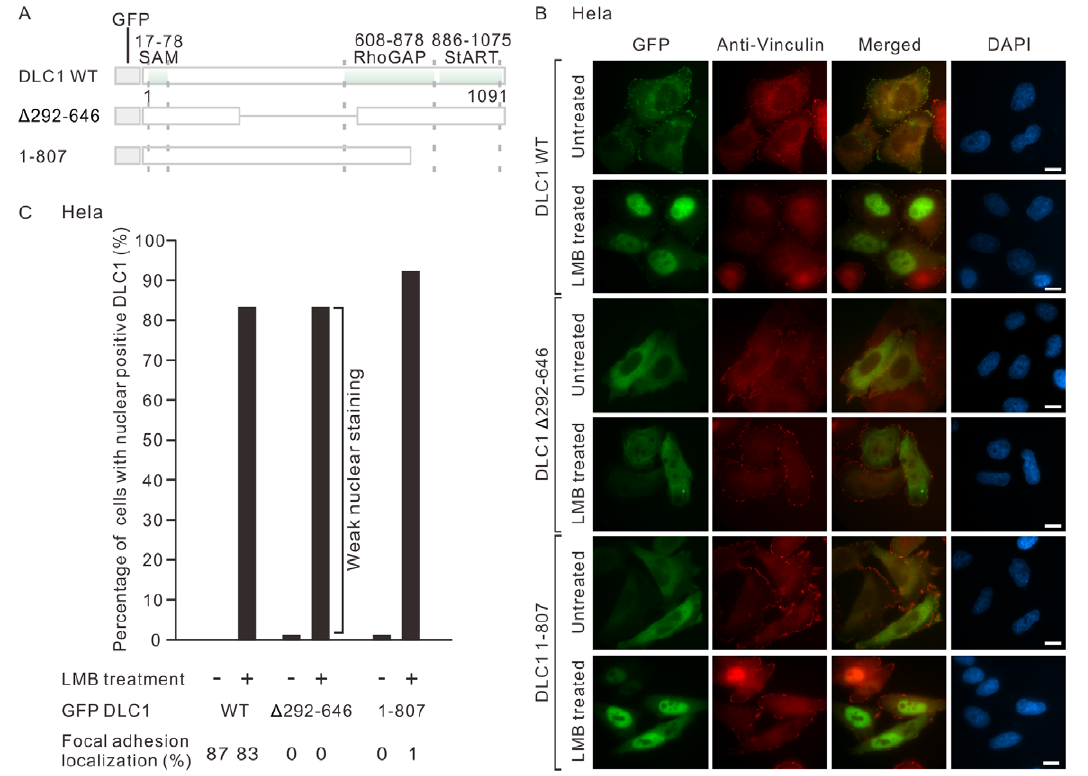
Figure 2. Center region of DLC1 was important for its nuclear localization. ( A ) Schematic diagram showing the structure of wildtype DLC1 (DLC1 WT) and its deletion mutants ( D 292–646 and 1–807). ( B ) HeLa cells were transiently transfected with the GFP-tagged DLC1 expression constructs as listed in (A), followed by LMB treatment. Focal adhesions were counterstained with anti-vinculin antibody. The subcellular localization of DLC1 was recorded by counting at least 100 transfected cells per sample. ( C ) Bar graph summarizing the subcellular localization of DLC1 and its mutants in (B) with or without the LMB treatment. The results represent a duplicate of two independent experiments. The percentages of focal adhesion positive DLC1 in individual group were also